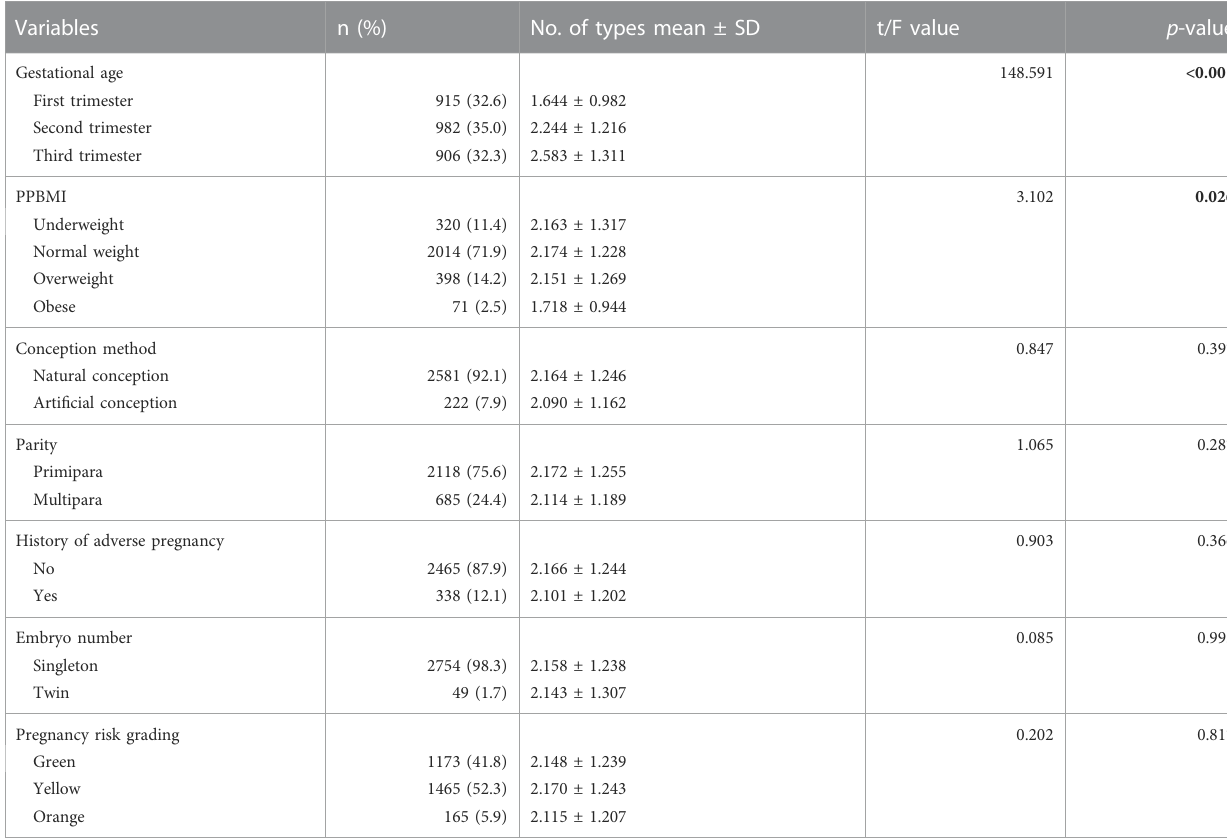
TABLE 2 Relationships in the use of different types of dietary supplements with women ’ s obstetric characteristics (N = 2803). Variables